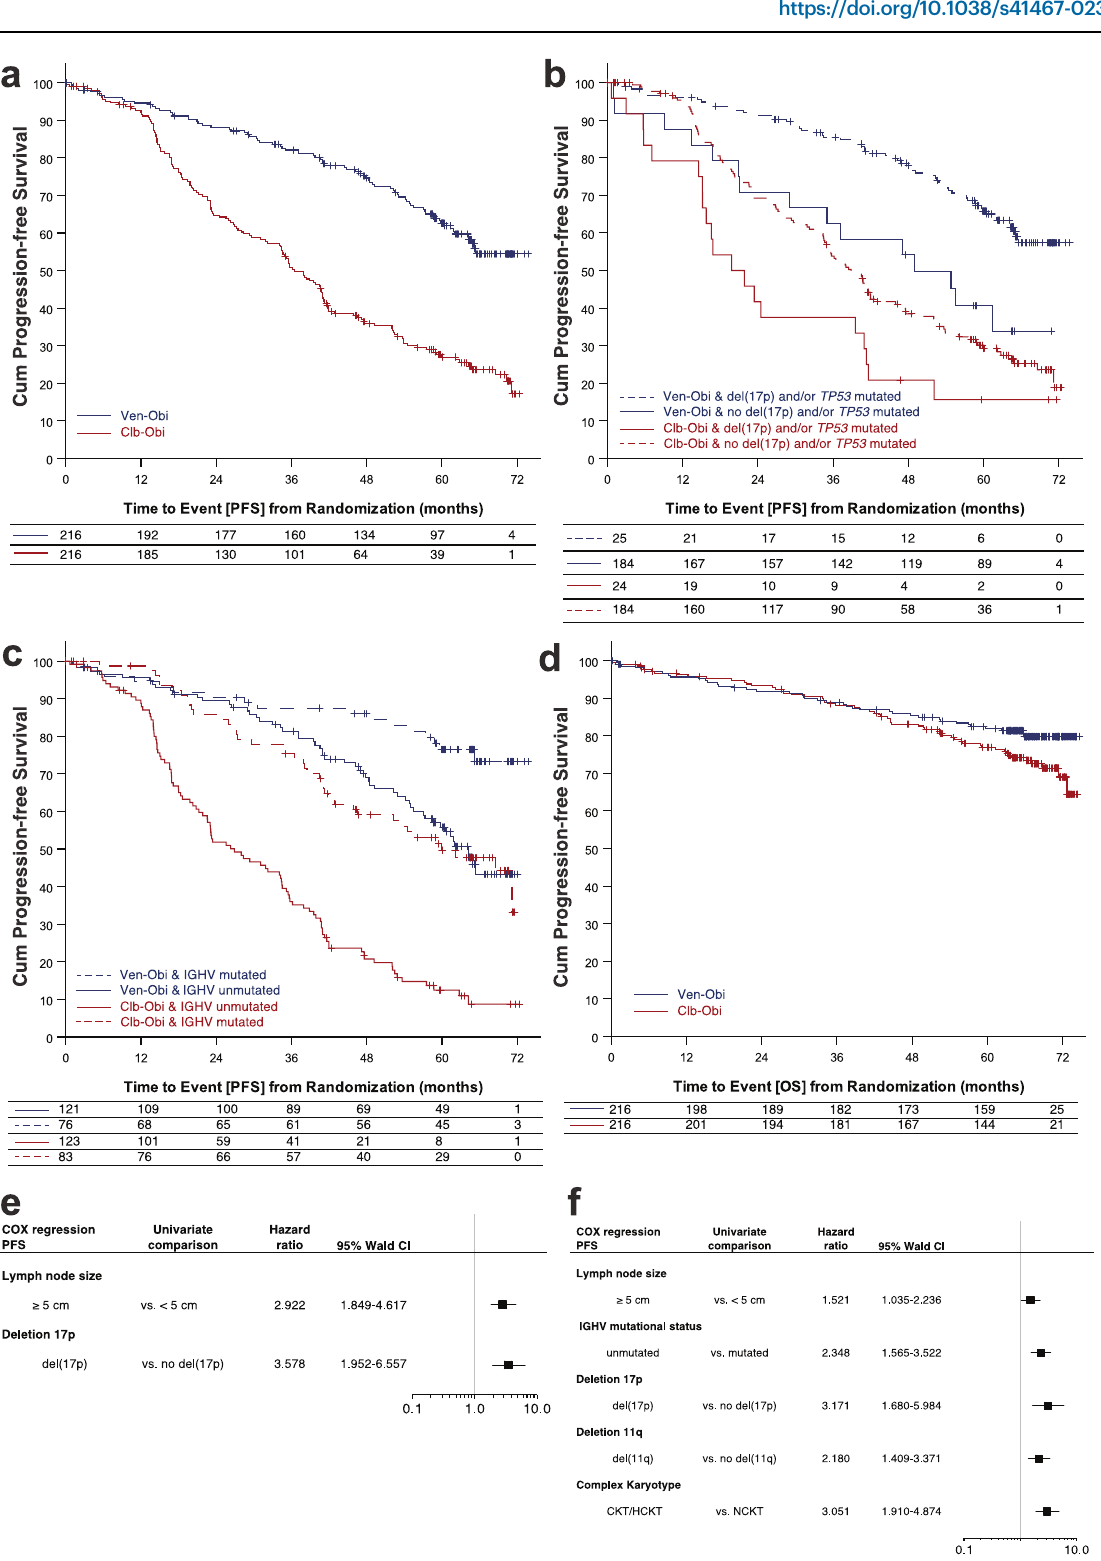
Ven-Obi arm ( n =194) and f in Clb-Obi arm ( n =179); horizontal bars in e and f represent95%con fi denceintervalsofhazardratios(indicatedbysquares)withthe vertical lines representing a hazard ratio of